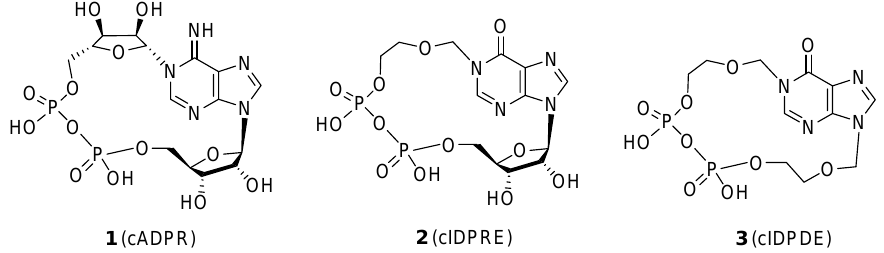
Figure 1. Structures of cADPR and its analogues.